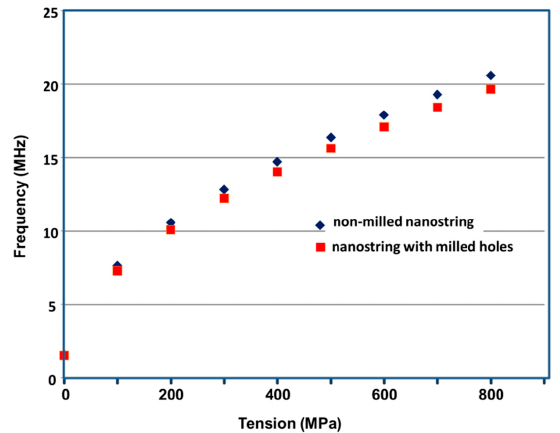
Figure 4. Finite element analysis of of the resonant frequency of SiCN nanostrings of length L = 15 m, width W = 200 nm and thickness t = 50 nm under varying tensile stress. Results for non-milled strings and strings milled with linear array of holes of diameter D = 45 nm and center-to-center spacing s = 120 nm are shown.